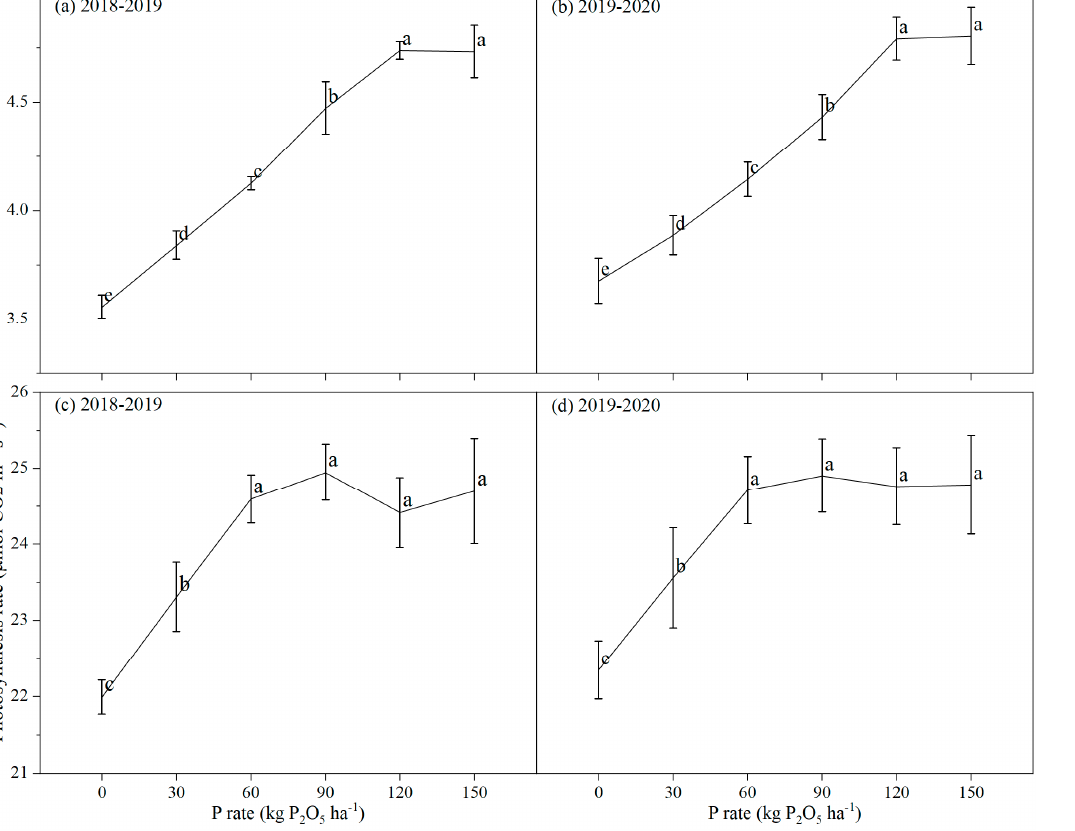
= 0.05 between P rate treatments. p